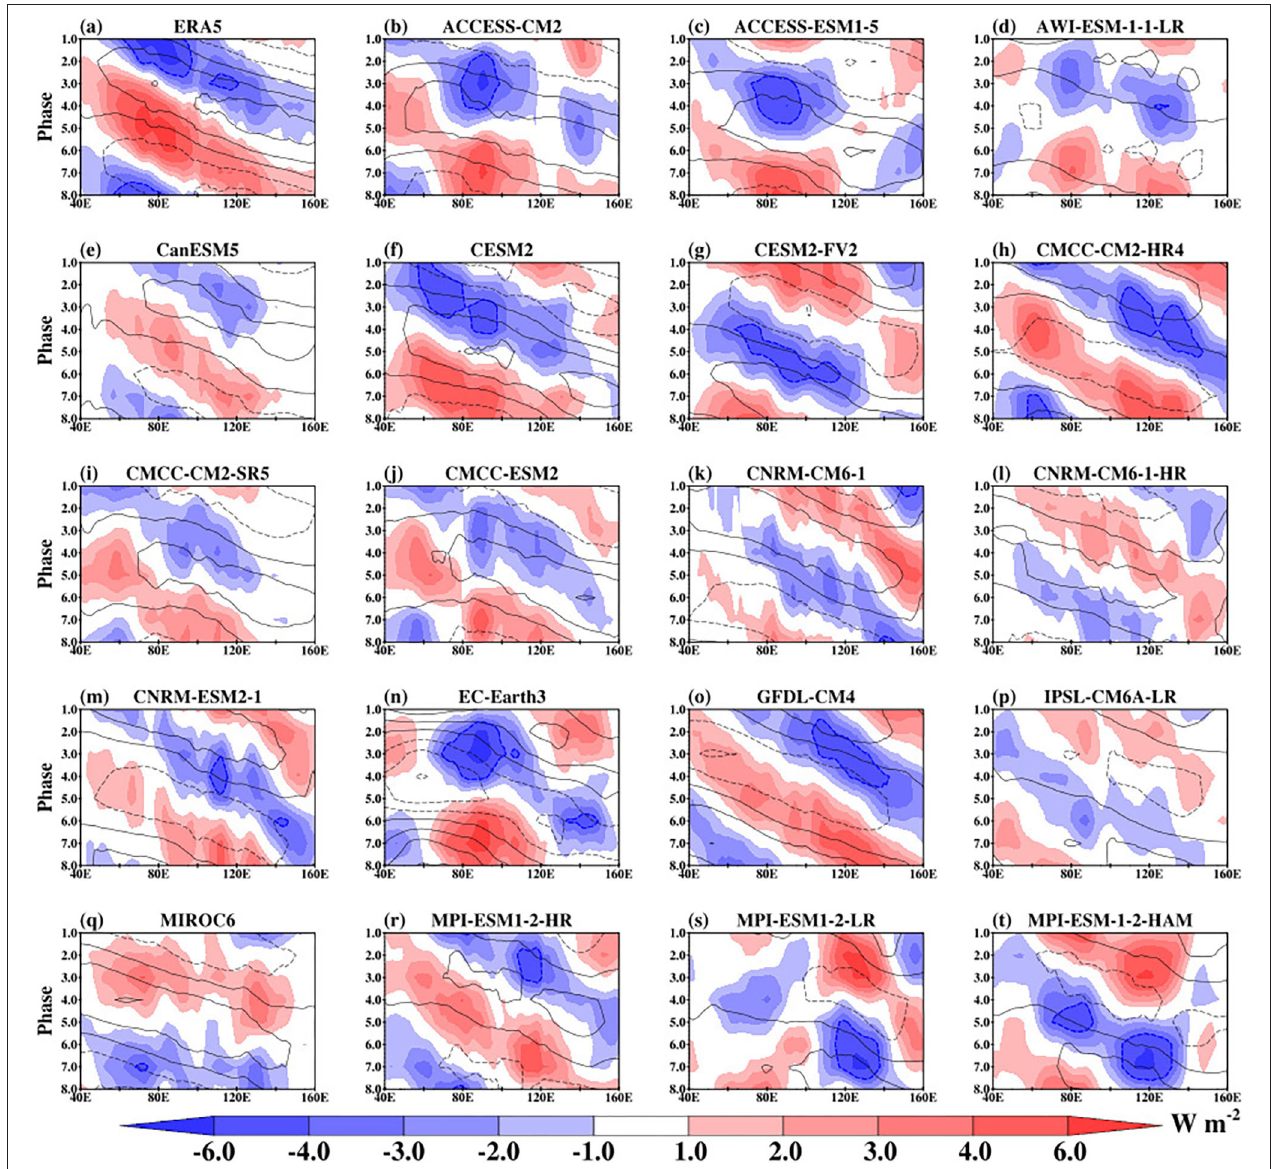
FIGURE 8 | ERA5 (a) and CMIP6 models (b–t) phase-longitude Hovmöller plot of composite May-October 30–60-day OLR (shaded) and U850 (contour) anomalies averaged between 10 ◦ S and 30 ◦ N.